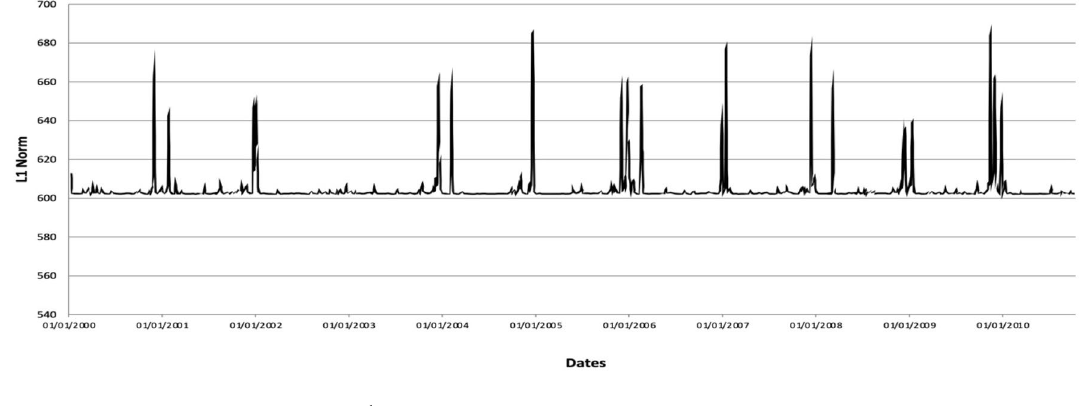
Figure 6. Time series of the L 1 norm of the zero-dimensional persistence landscapes of the time-ordered sequence of sliding windows.